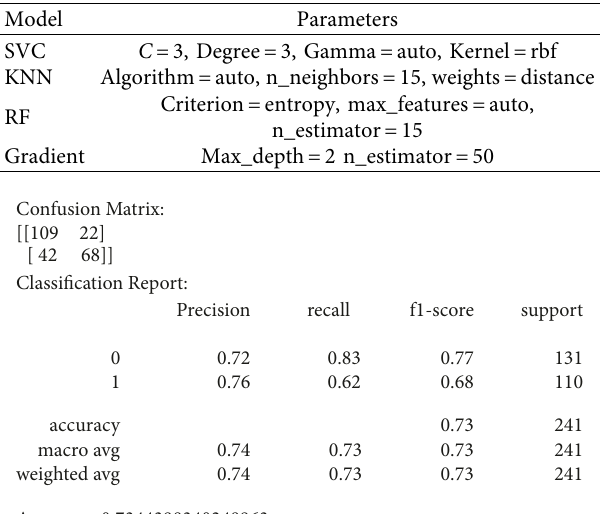
Table 4: List of parameters used for configuration of the traditional method of machine learning.